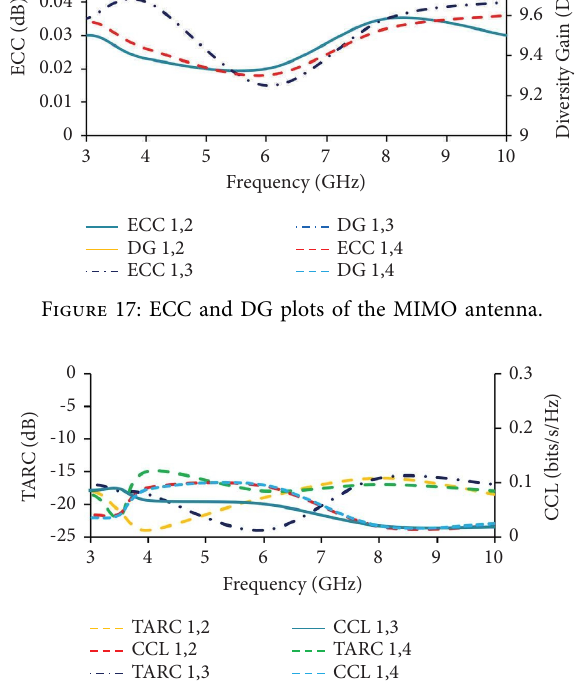
Figure 18: TARC and CCL plots of the MIMO